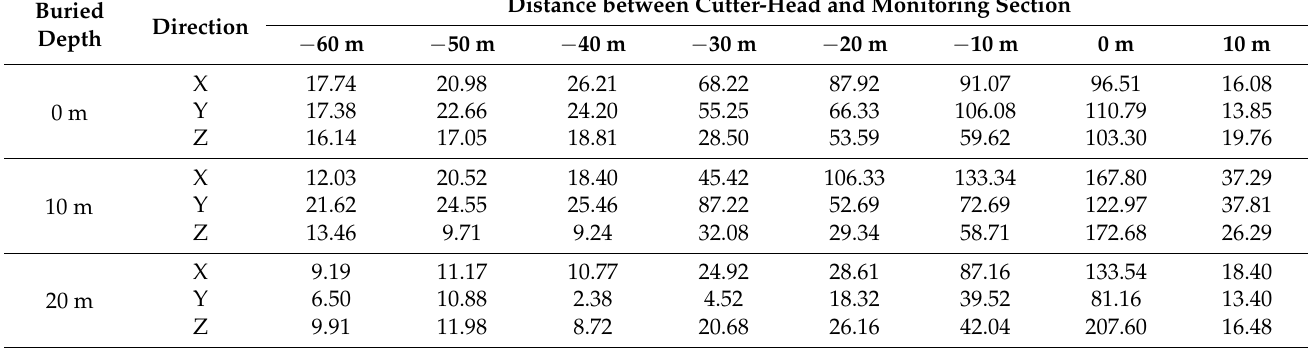
Table 4. Peak accelerations of sampling hole Z-4 (unit: mm/s 2